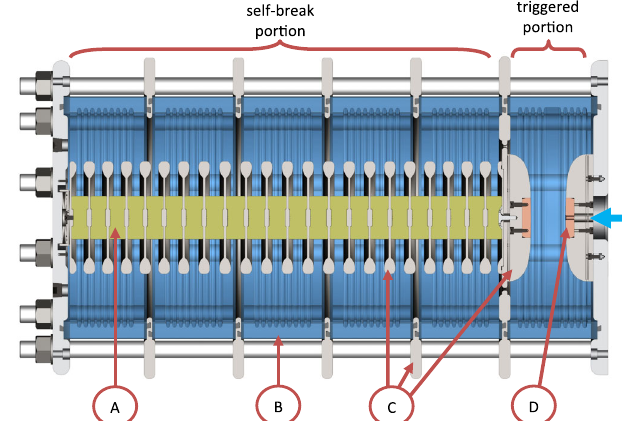
FIG. 1. (Color) Cross section of the refurbished Z at Sandia National Laboratories [8]. The 36 Marx generators, 36 water insulated intermediate storage capacitors, and 36 laser-triggered gas switches are submerged in mineral oil for electrical insu- lation. The pulse-forming lines and pulse-sharpening switches are submerged in deionized and degassed water. A multilevel insulator stack separates the water section from the central vacuum region where magnetically insulated transmission lines transmit power to the load.